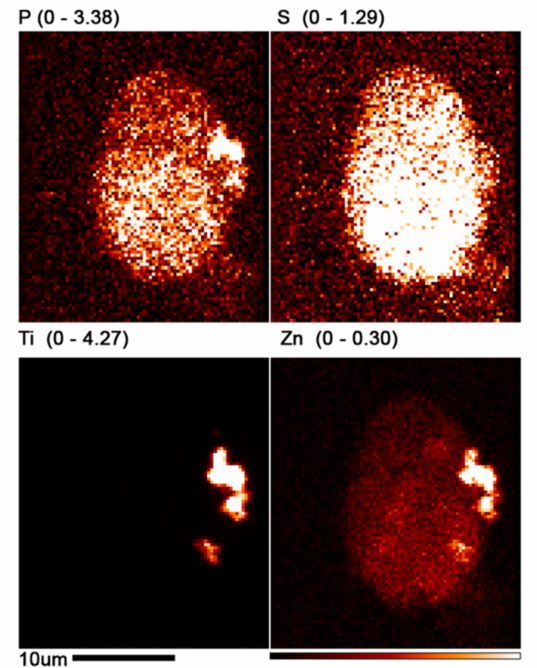
Figure 9. High resolution XFM scan of the cell selected in Figure 8. The map for P suggests that